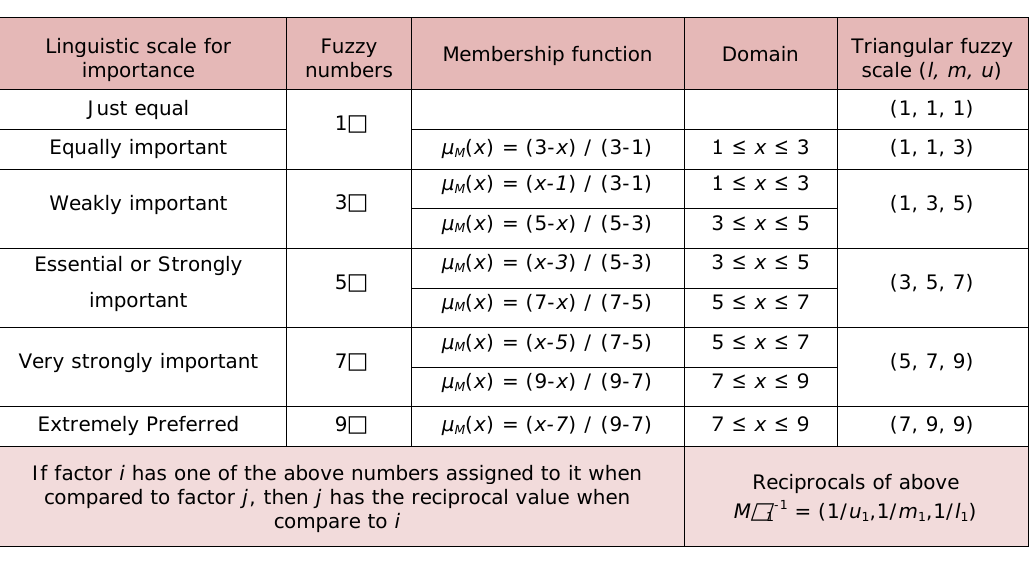
Table 1. “Linguistic variables describing weights of the criteria and values of